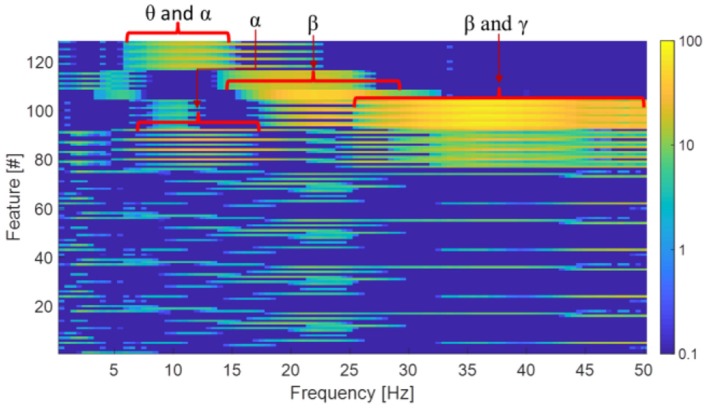
Analysis of the features extracted by the convolutional layers vs. the input frequency. For ease of visualization, feature values are shown in a log scale.